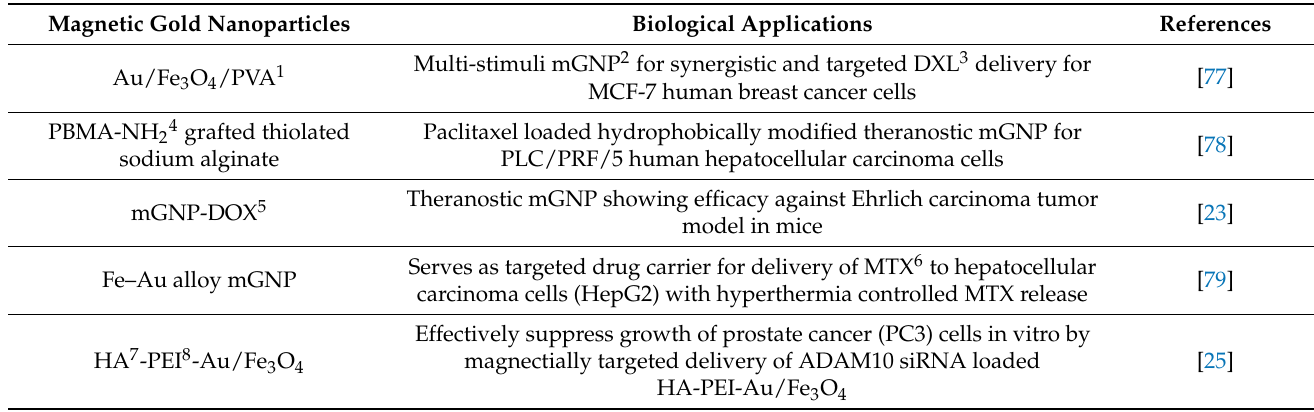
Table 2. Applications of magnetic gold nanoparticles in biological